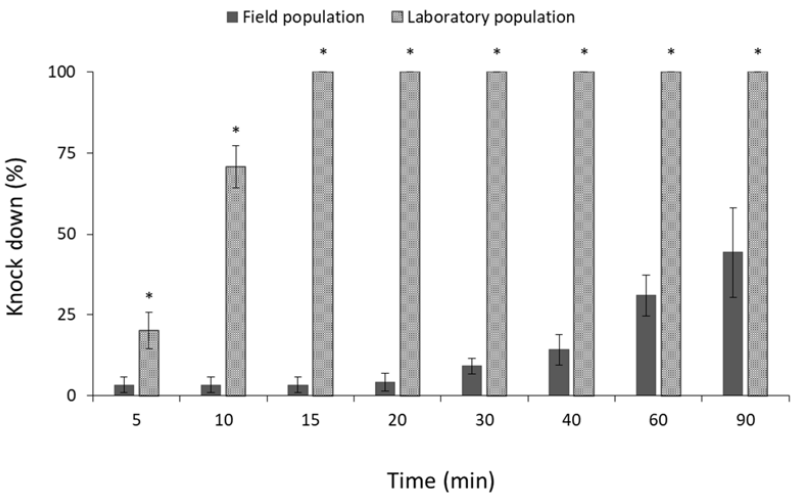
Figure 12. Mean (% ±SE) of knocked ‐ down adults of field and laboratory populations of C. ferrugineus , after exposure to phosphine at 3000 ppm for different observation intervals (in min). Within each exposure interval, means with asterisk (*) indicate significant differences between the populations, according to Students’ t –test at p < 0.05.